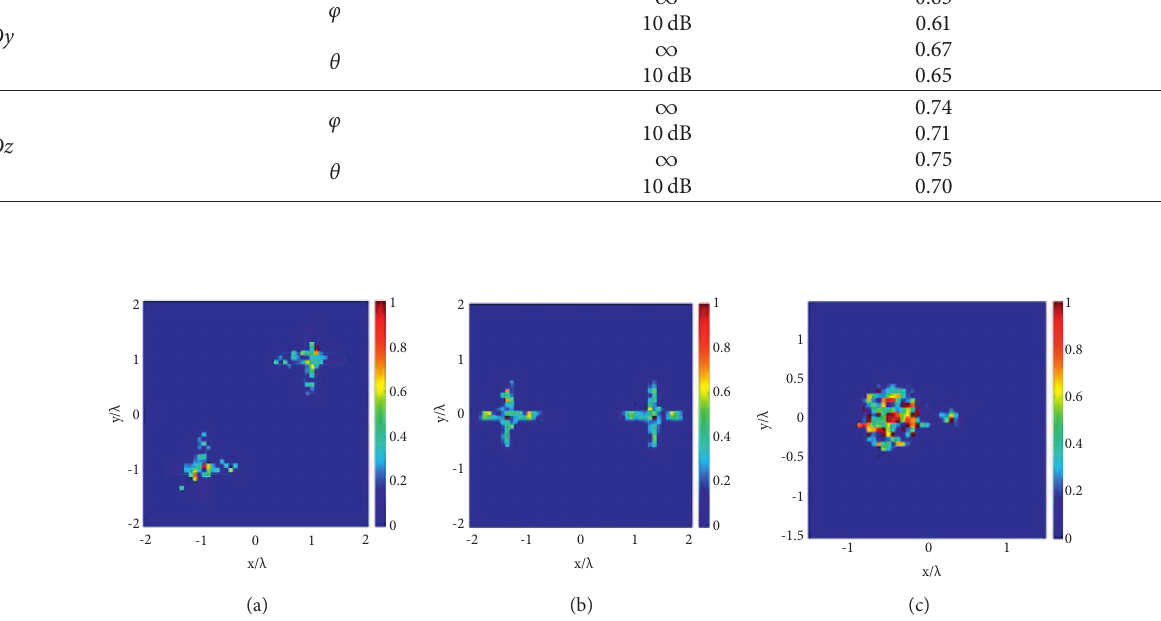
Figure 8: Reconstruction of two objects in xOy plane and φ -oriented dipoles. The adopted signal-to-noise ratio was SNR � 10dB.